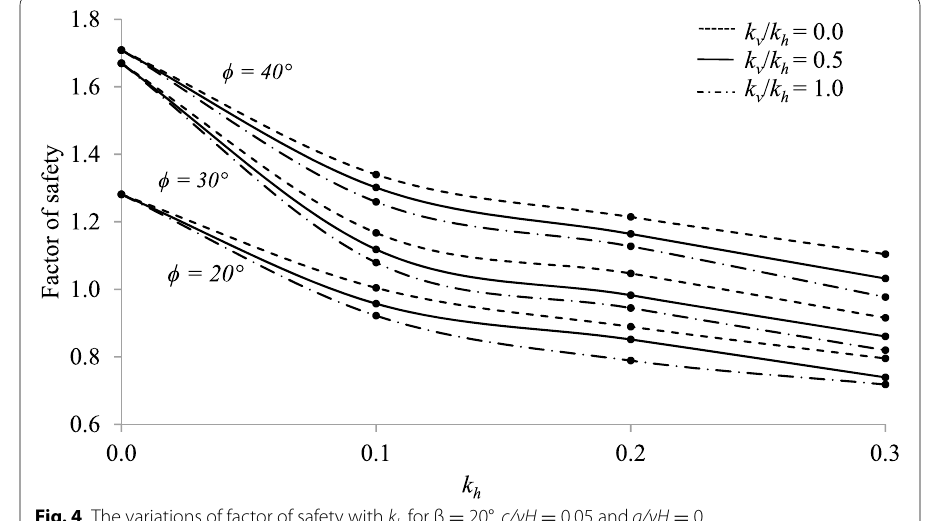
Fig. 4 The variations of factor of safety with k h for β